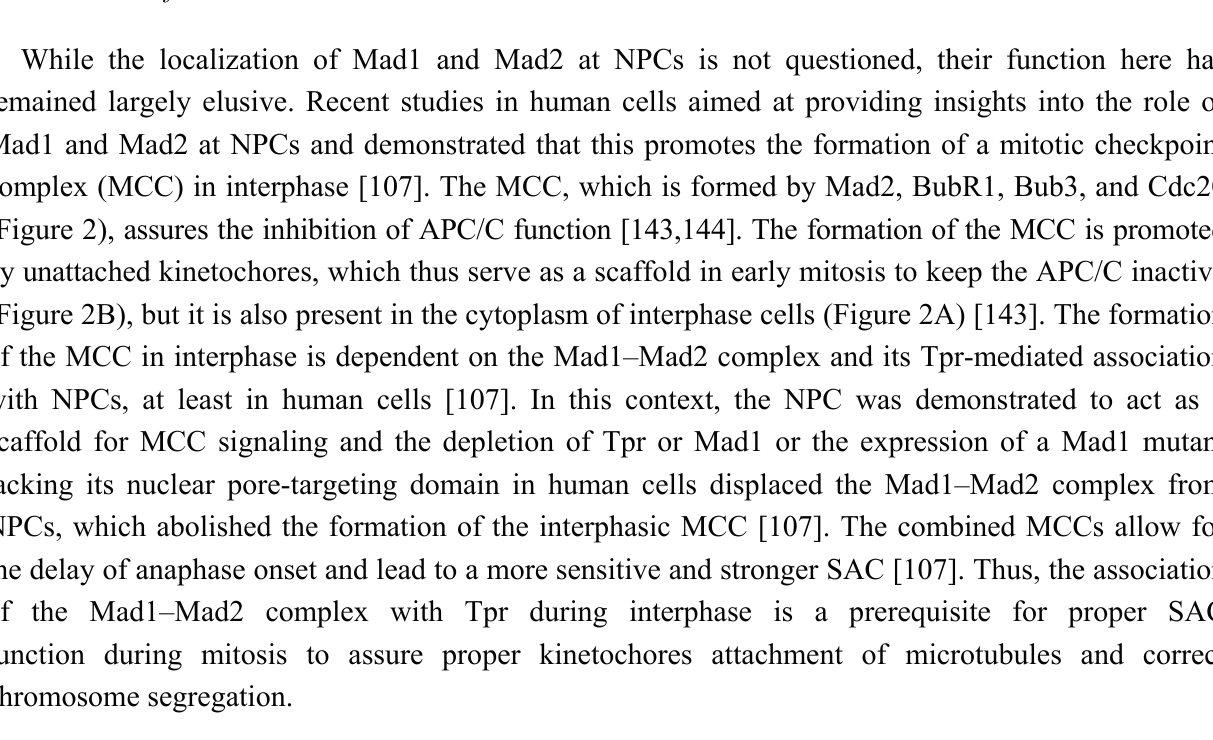
Nucleoporins Partners